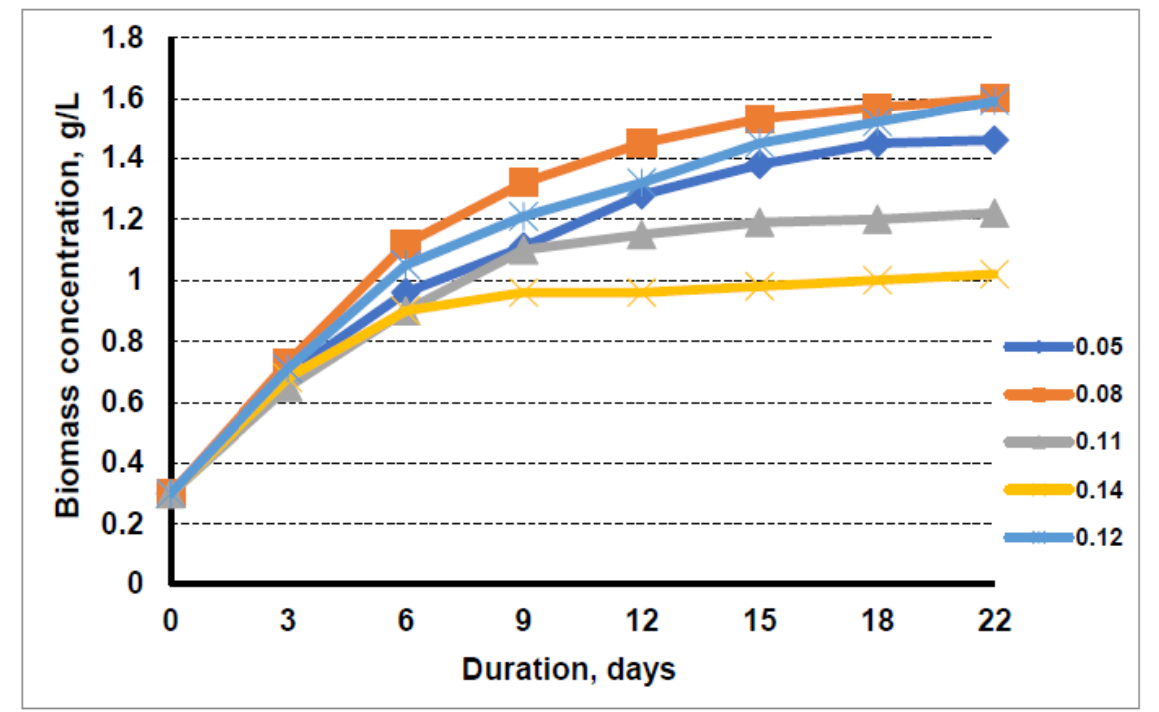
Figure 2. Growth dynamics of microalgae in nutrient medium with the liquid fraction after biogas production from sewage sludge at nitrogen concentrations of 0.05 g/L, 0.08 g/L, 0.11 g/L, 0.14 g/L, and 0.12 g/L (medium-control).